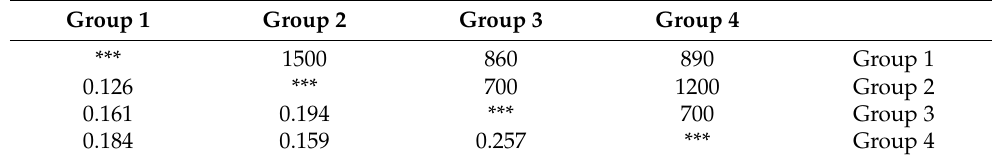
Table 6. Nei’s unbiased genetic distance (detected by the combination of RAPD and ISSR markers) and geographic distance between pairs of the groups of Meloidogyne javanica populations in Iran.